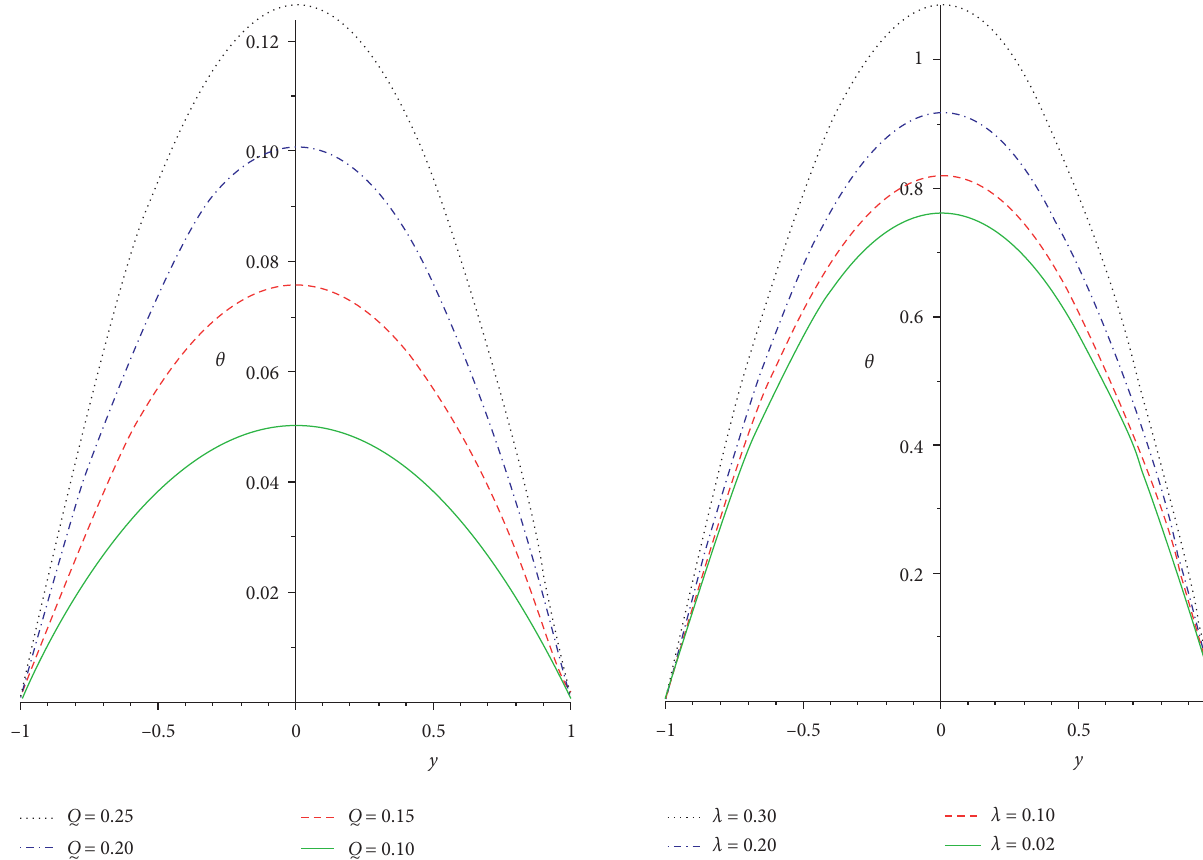
Figure 7: Heat profile for different values of λ